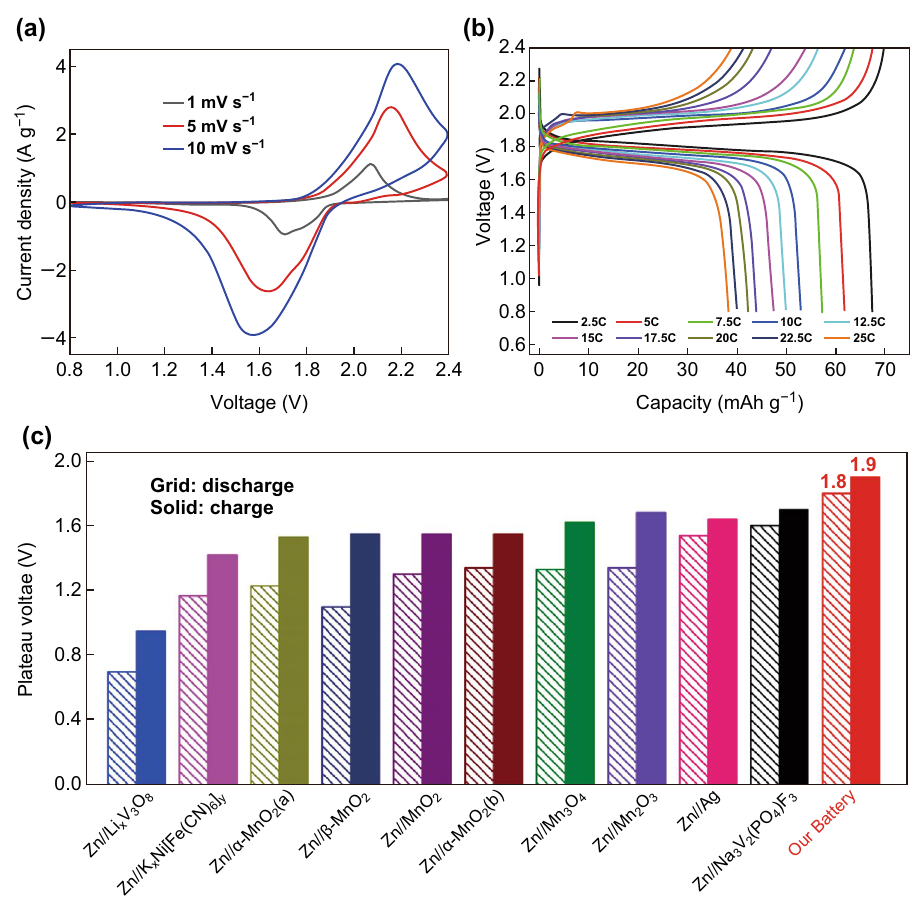
Fig. 3 a CV curves of the ZIB at different scan rates of 1 mV s −1 (black), 5 mV s −1 (red) and 10 mV s −1 (blue). b Charge/discharge profiles from 2.5 to 25 C (1 C = 80 mA g −1 ). c Plateau voltage comparison of various ZIBs in previous reports. (Color figure